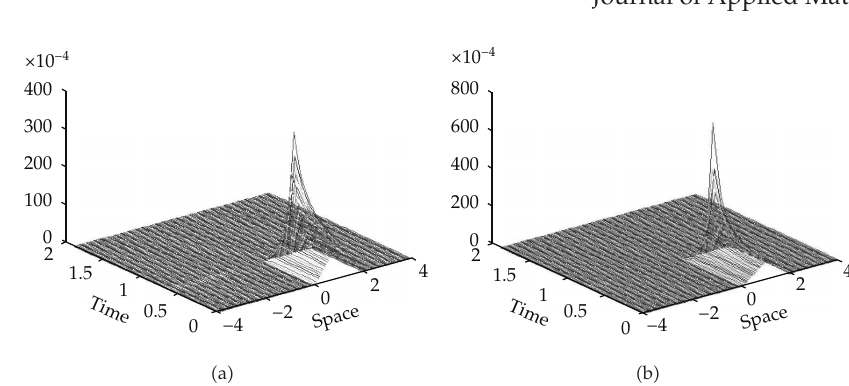
Figure 1: Evolution in time, nonsymmetric datum.